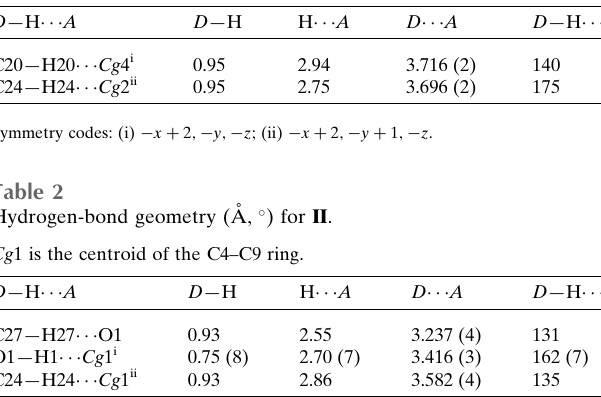
Table 1 Hydrogen-bond geometry (A˚ , (cid:3) ) for I . Cg 2 and Cg 4 are the centroids of the C10–C15 and C22–C27 rings, respectively.